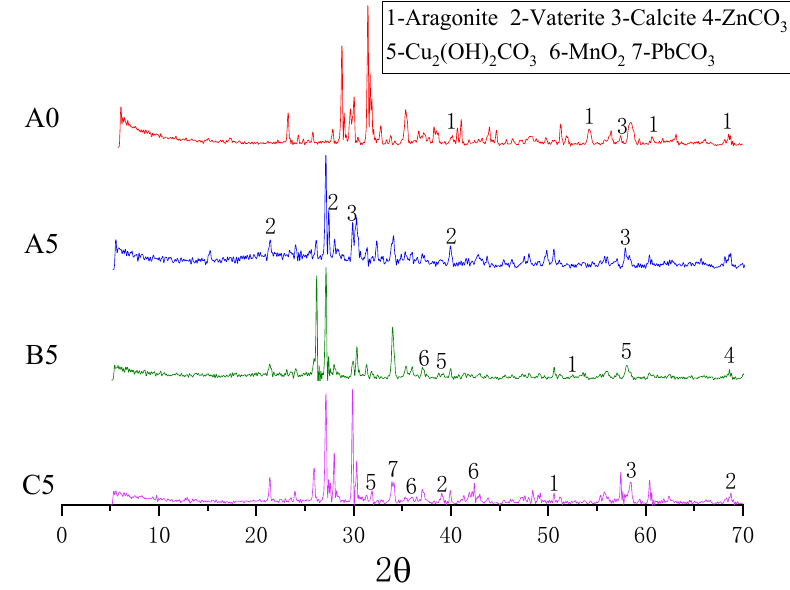
Figure 4. XRD results of A0, A5, B5, and C5.